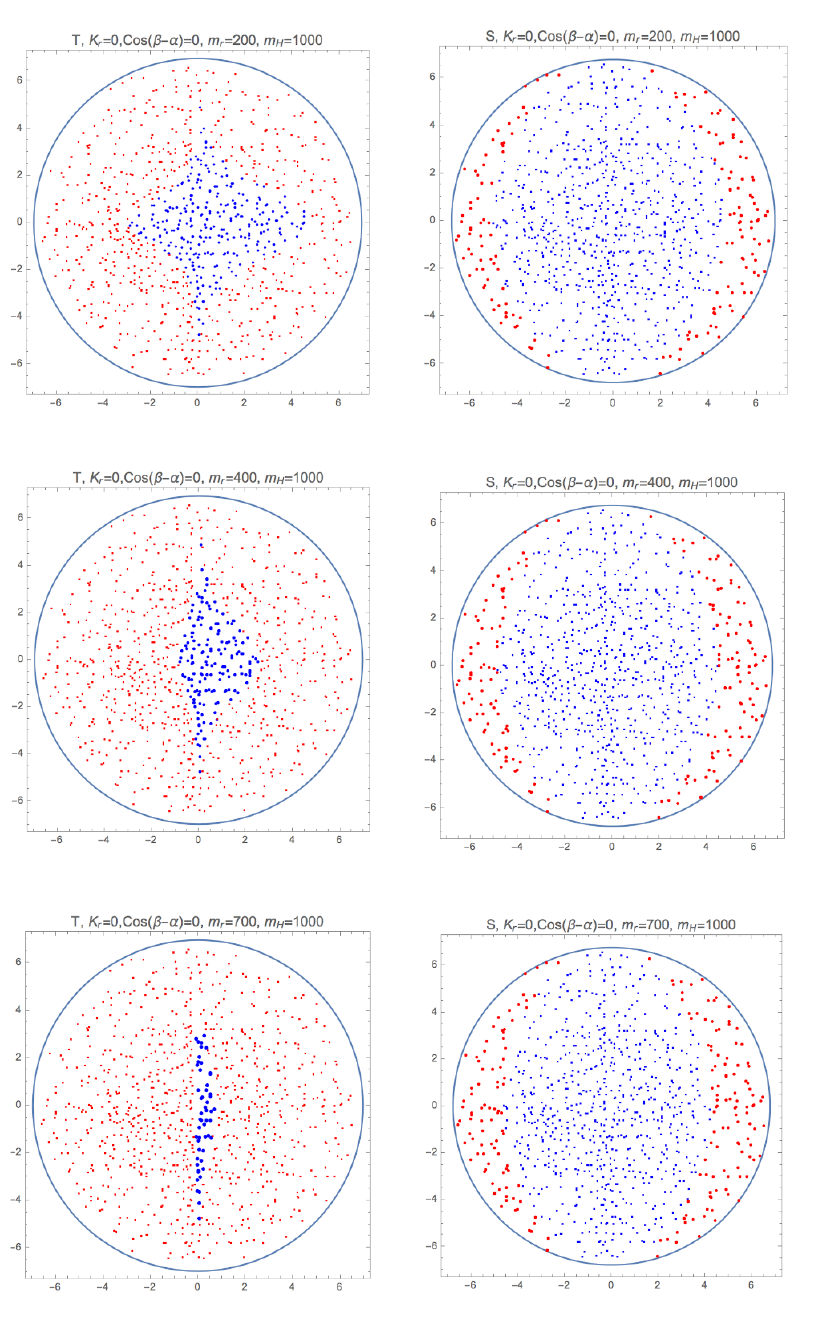
Figure 3 . Constraints on K H (y-axis) and K h (x-axis) from the S and T parameters. The circle is the theoretically allowed region, the blue dots are allowed by the S and T parameter bounds, and the red dots are disallowed. The other parameters chosen are listed at the top of the (cid:12)gures with m A = 500 GeV and (cid:3) = 5 TeV.